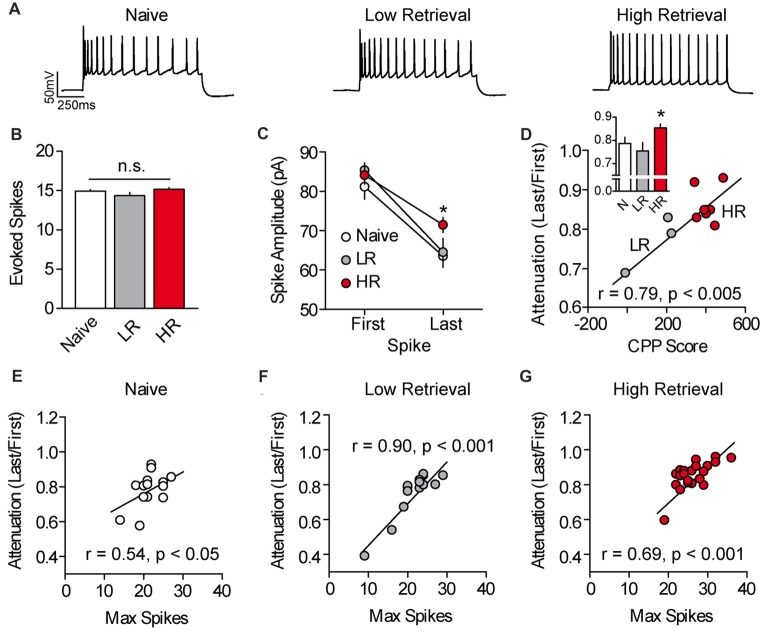
Spike amplitude attenuation of PL-mPFC pyramidal neurons is reduced in HR rats and correlates with intrinsic excitability. (A) Representative waveforms showing a current-evoked depolarizing step. (B) Current was adjusted so that roughly 15 action potentials fired per sweep. (C) The amplitude of the last, but not first, action potential had higher amplitude in neurons from HR rats vs. neurons from naïve and LR rats. (D) Spike amplitude attenuation in PL-mPFC pyramidal neurons from each rat correlated with CPP scores. Inset shows that spike amplitude attenuation was reduced in HR rats vs. neurons from naïve and LR rats. (E–G) Spike amplitude attenuation correlated with the maximum number of action potentials fired in each neuron for naïve rats (E), LR rats (F) and HR rats (G). Line and bar graphs represent the mean ± SEM. HR, high retrieval; LR, low retrieval; *p < 0.05 vs. control.